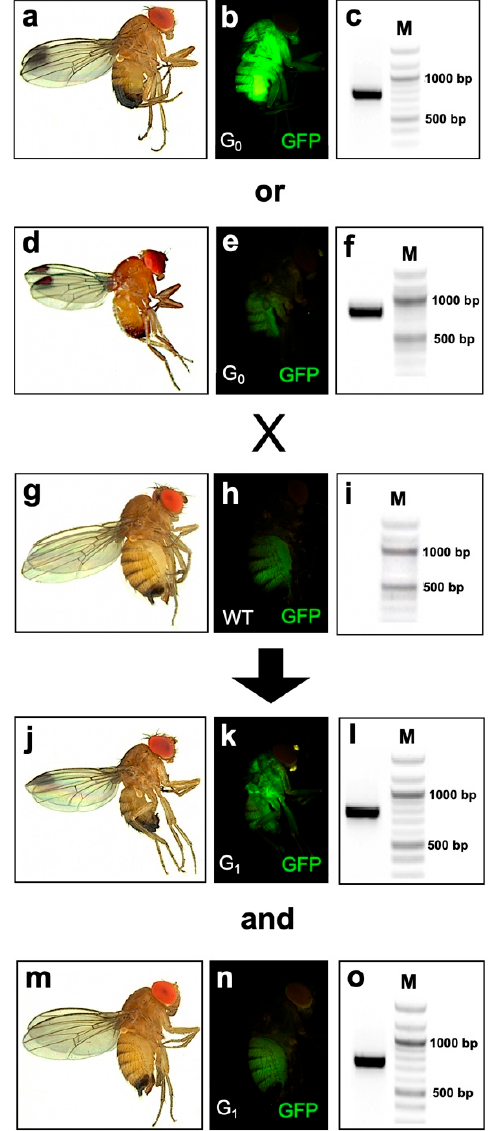
Figure 2. Crossing scheme of G 0 individuals injected with gRNA targeting EGFP gene and molecular analysis of G 0 and G 1 flies. Shown are fly images in bright field ( a , d , g , j , m ) and the corresponding GFP filter ( b , e , h , k , n ) as well as the respective PCR validating the presence or absence of the EGFP marker gene ( c , f , i , l , o ). M: molecular ladder. After the injection of gRNA-expressing plasmid or in vitro synthesized gRNA, V265_M7m1 G 0 individuals, which are homozygous for the EGFP marker gene, showed either strong whole-body fluorescence ( b ) or no fluorescence ( e ) that is similar to the phenotype ( h ) of wild type (WT). Those G 0 were individually crossed to WT flies, and G 1 offspring was either heterozygous for the EGFP ( k ) and positive in EGFP -specific PCR (I), or phenotypically missing the EGFP fluorescence ( n ), but still carrying the EGFP gene ( o ). PCR product size for EGFP is 782 bp. M = molecular ladder; bp = base pair.